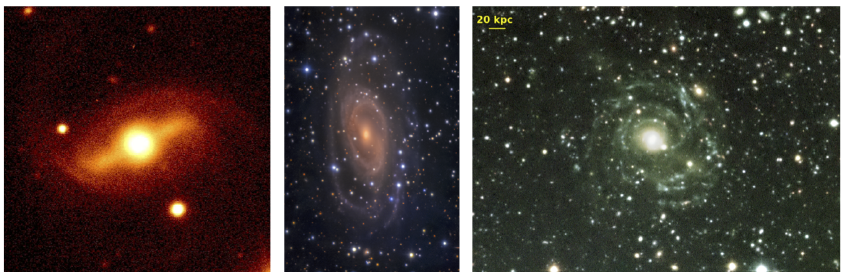
Figure 10. Peculiar LSBs ( left ) the barred LSB galaxy UM163 from [197]. ( center ) UGC 1378 [198] a giant galaxy with a central high surface brightness disc surrounded by an extended LSB disc. ( right ) The giant LSB galaxy Malin 1 from [199].